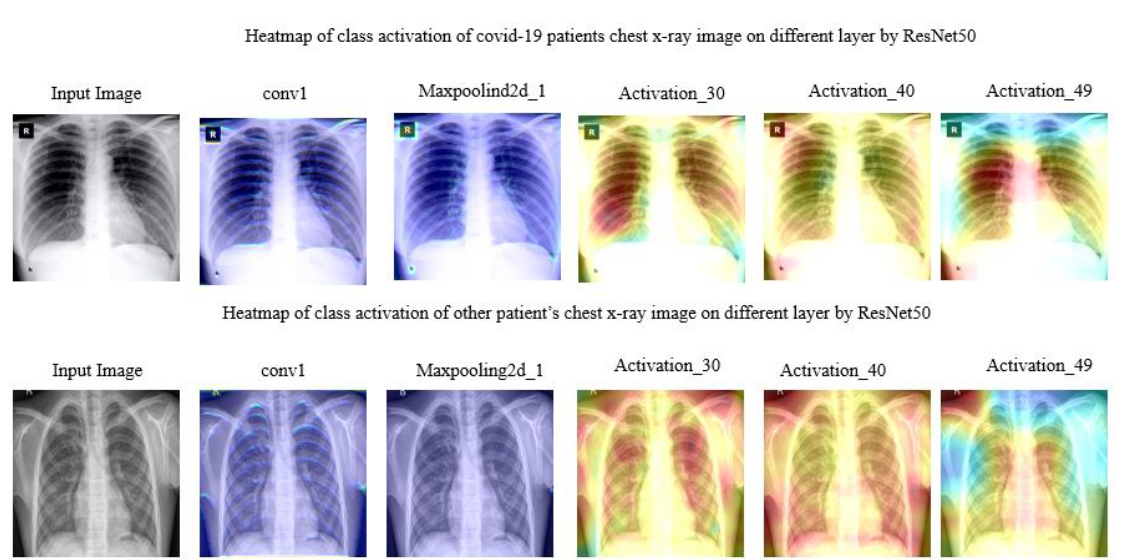
Figure 7. Heat map of class activation of chest X-ray image on different layer acquired by ResNet50.